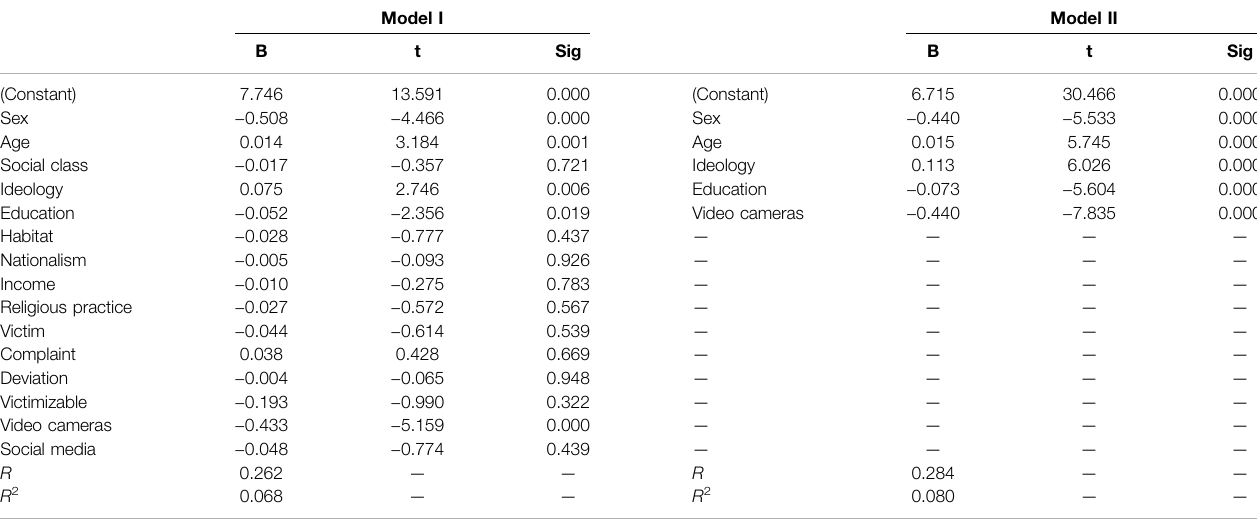
TABLE 5 | Regression analysis multiple (Dependent variable =